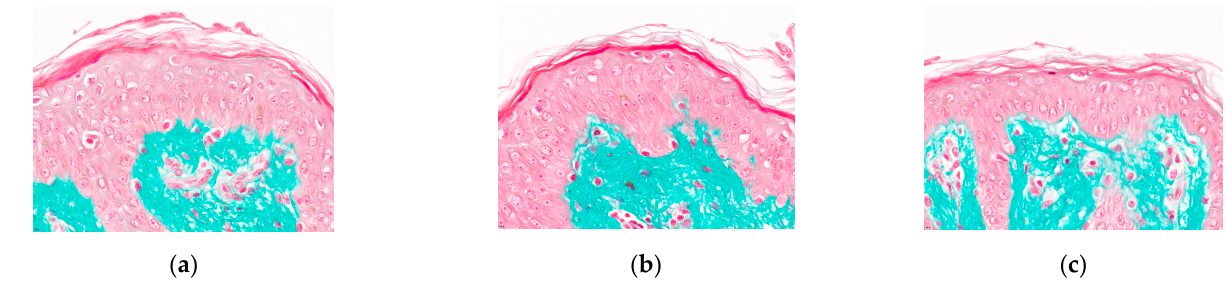
Figure 4. Cell viability of the untreated control on day 6 ( a ), of the batch treated with 0.05% w/w of the Melissa officinalis phytocomplex on day 6 ( b ) and of the batch treated with 0.1% w/w of Melissa officinalis phytocomplex on day 6 ( c ).